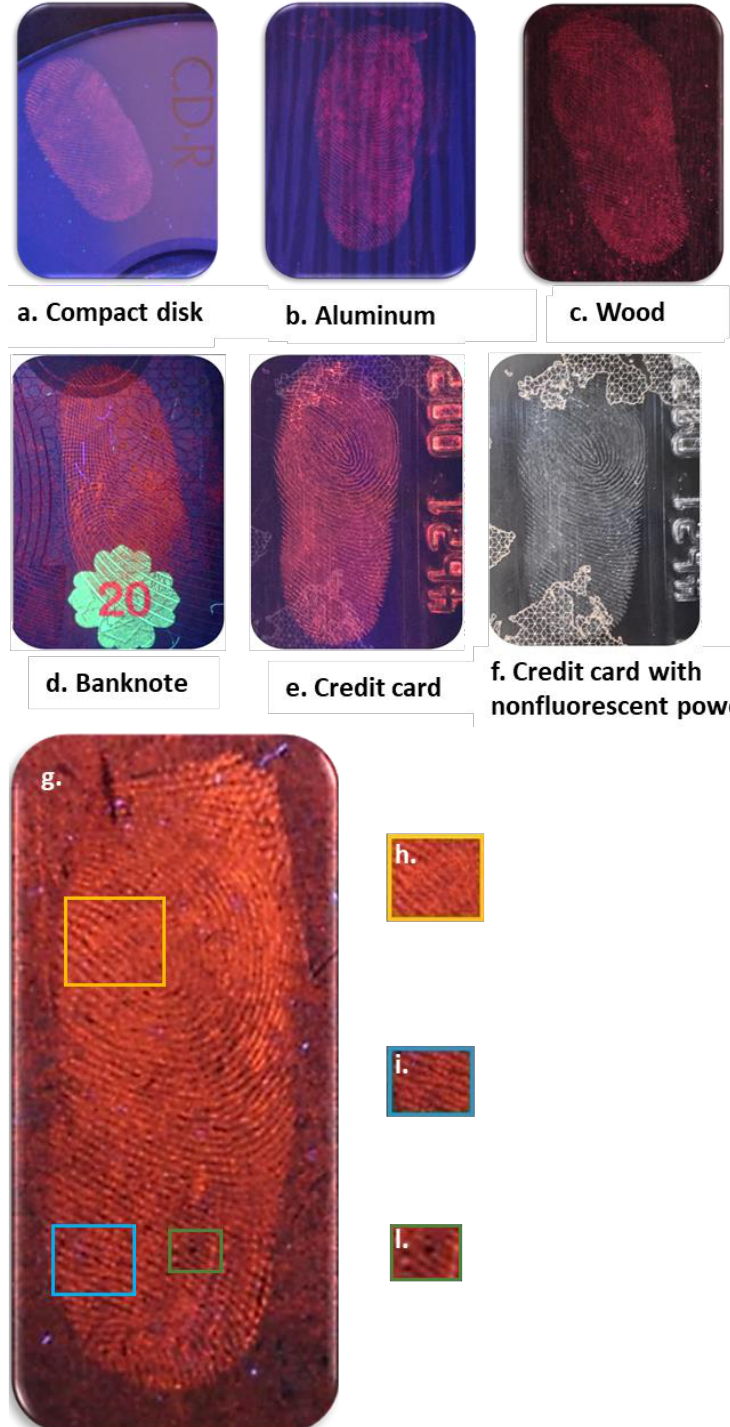
Figure 5. Developed fingerprint images obtained with Eu:Y 2 Sn 2 O 7 on different surfaces: ( a ) compact disc, ( b ) aluminum foil, ( c ) wood, ( d ) banknote, ( e ) credit card, ( f ) credit card with nonluminescent powder. ( g ) Enlargement of ( c ) with the three levels of fingerprint ridge patterns visualized: ( h ) core (Level 1); ( i ) bifurcation and termination (Level 2); ( l ) sweat pores (Level 3).